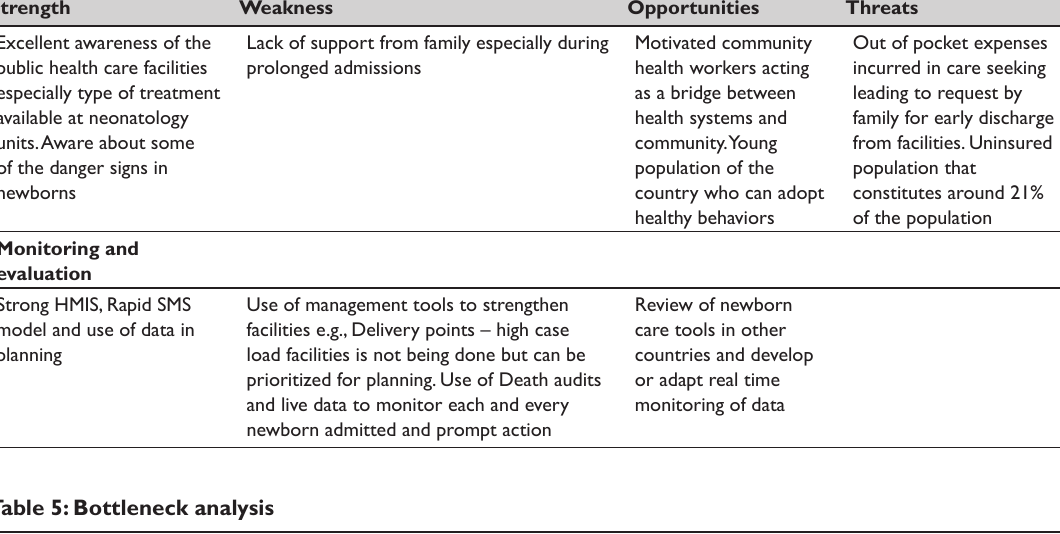
Table 5: Bottleneck analysis Social